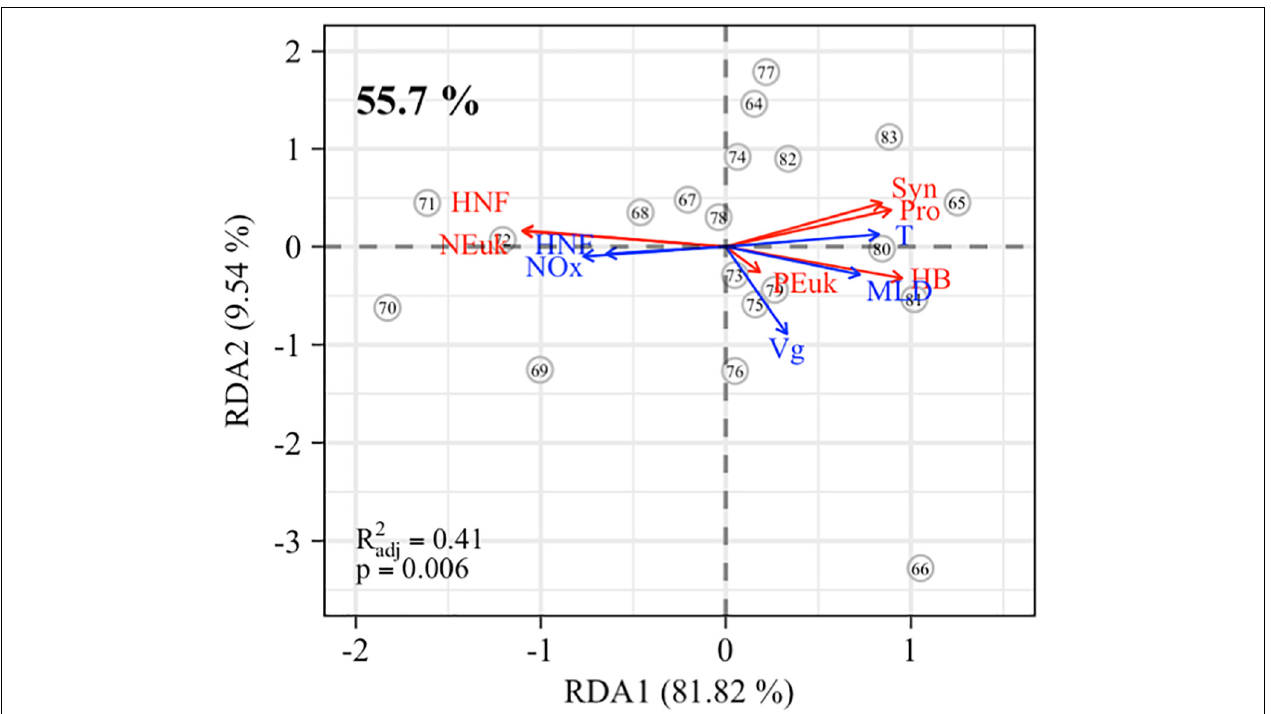
FIGURE 7 | Results of the correlation plot of db-RDA, for the integrated biomasses of the different plankton groups (red arrows: Pro, Prochlorococcus ; Syn, Synechococcus ; PEuk, picoeukaryotes; NEuk, nanoeukaryotes; HB, heterotrophic bacteria; HNF, heterotrophic nanoflagellates) and the physical-biogeochemical variables (blue arrows: T, potential temperature; MLD, mixed layer depth; Vg, geostrophic velocity; NO x , nitrate + nitrite; HNF, heterotrophic nano flagellates). Stations are indicated by open dots. Note that distances among stations are not approximated to ecological distances. The explained variance for canonical axes RDA1 and RD2 is given on the axis. The percentage on the upper left corner refers to the explained constrained variance by all canonical axes. The adjusted correlation coefficient (R 2 adj ) and the Monte Carlo permutation test p -value are also shown in the lower left corner.